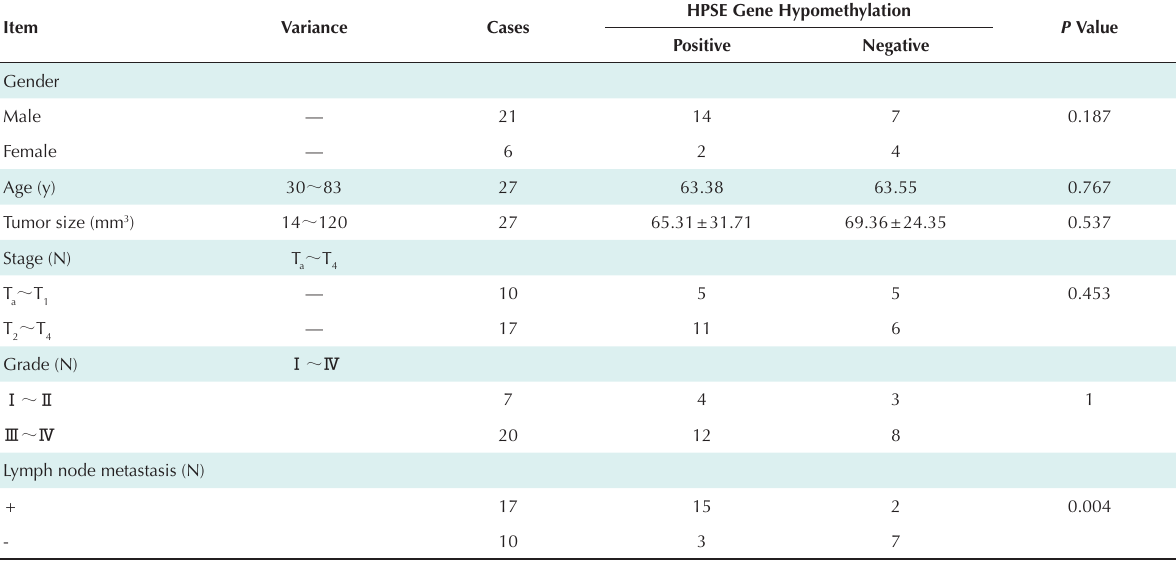
Table 1. The Relationship Between Clinicopathologic Features in BC and HPSE Gene